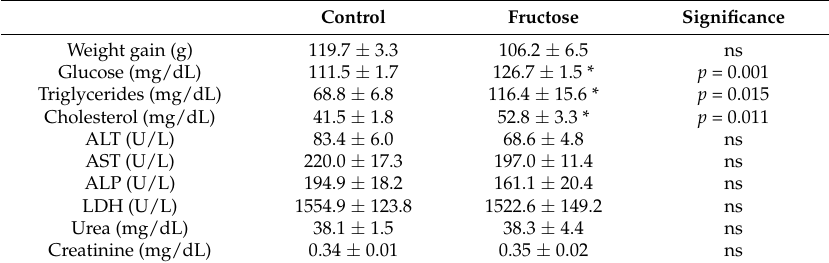
Table 1. Effects of the chronic intake of fructose on metabolic